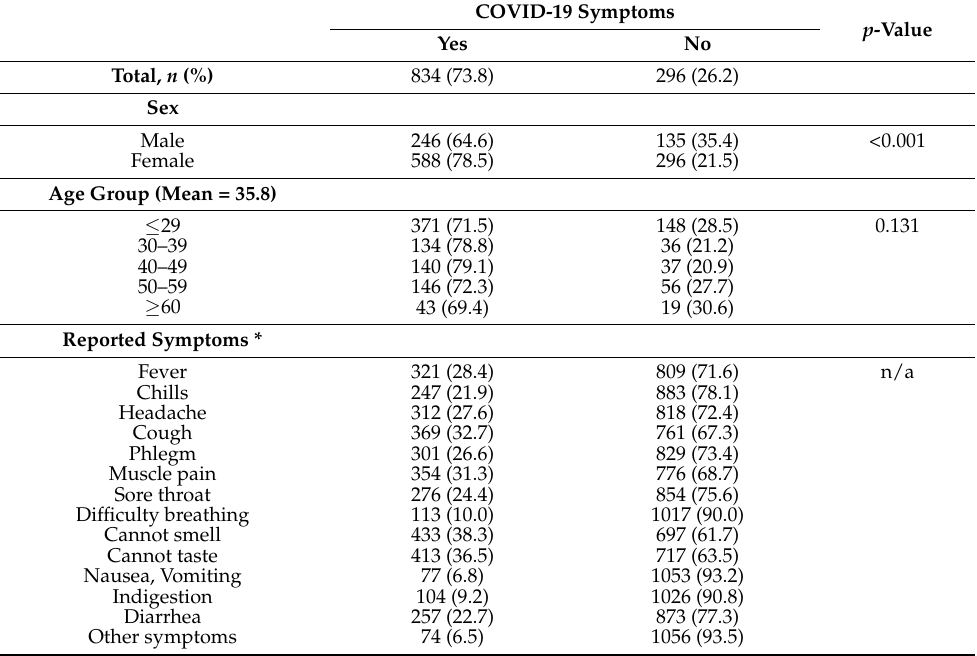
Table 3. Symptoms of infection in confirmed COVID-19 patients ( n = 1130).